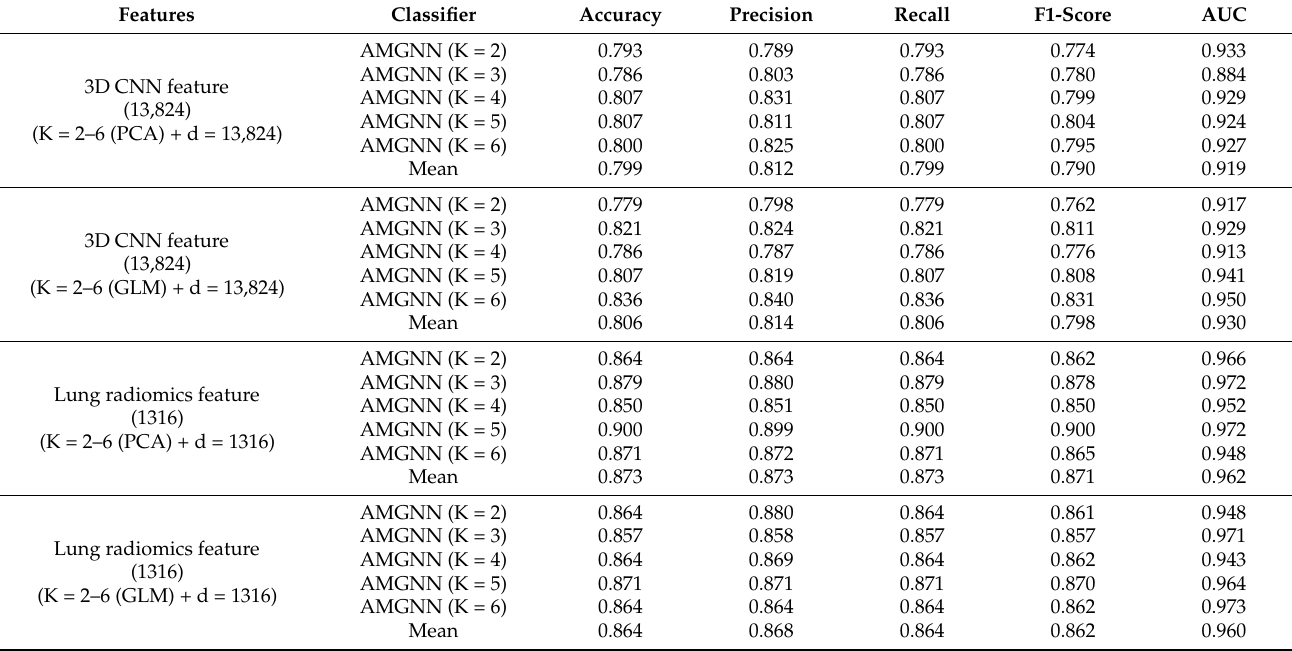
Table 8. The AMGNN classifier’s performance on the test set in Experiment